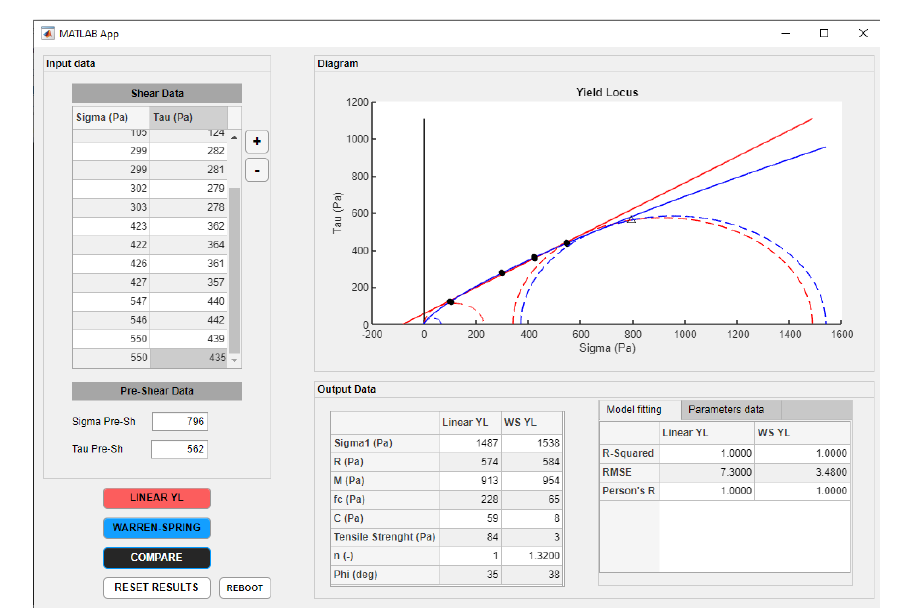
Figure 4. CYield App general view reporting, as an example, the use of the experimental results for the sample CP2 at the pre ‐ shear load of 0.614 kg.